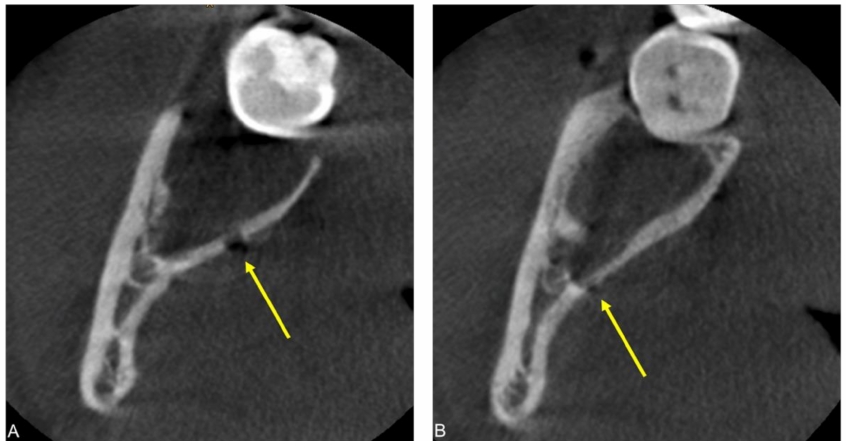
Figure 3. Postoperative cone-beam computed tomography (CBCT) scan of a patient complaining of persistent numbness of the right side of the tongue two weeks after bilateral MTM surgery. Axial CBCT image reconstructions ( A , B ) visualize two possible iatrogenic defects of the lingual cortical bone: a spherical lesion at the level of the former crown and a linear defect distal to the level of the former cementoenamel junction of the